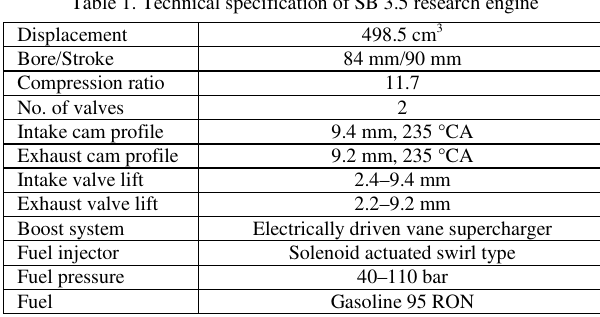
Table 1. Technical specification of SB 3.5 research engine